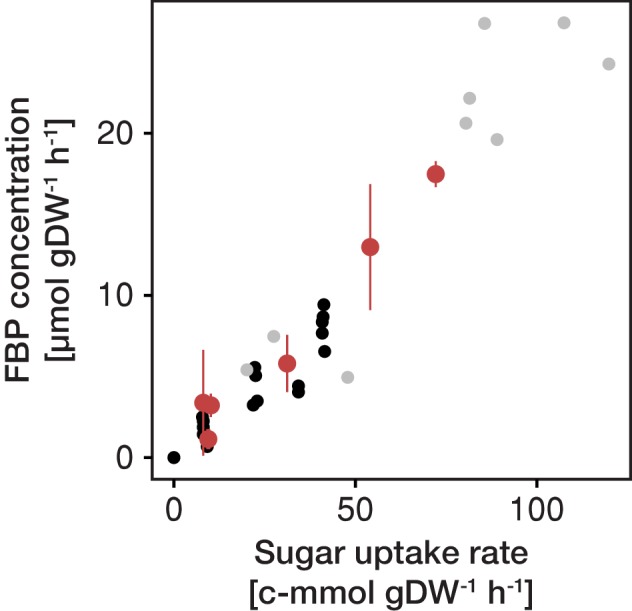
FBP (fructose-1,6-bisphosphate) concentration as function of sugar uptake rate.Fructose-1,6-bisphosphate is a glycolytic flux-signaling metabolite and its concentration strictly correlates with the carbon flow through the glycolysis or the sugar uptake rate (Huberts et al., 2012). The independently inferred rate of glycolysis and FBP concentration in aging cells follows this correlation, providing evidence for the validity of the two independently generated data sets, that is physiological rates and metabolite levels. Black dots (Christen and Sauer, 2011), grey dots (de Assis Souza, 2016) and red dots inferred for aging cells.